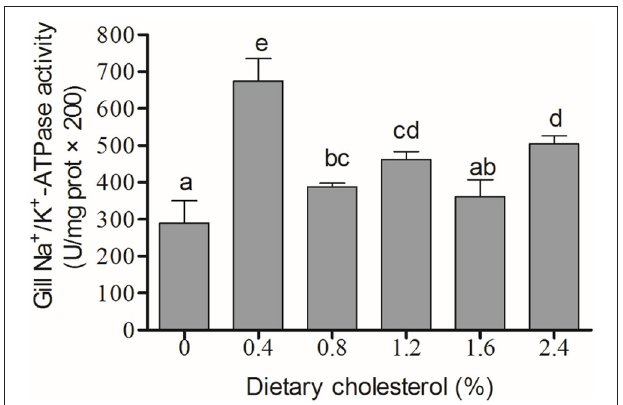
FIGURE 3 | The activity of Na + /K + -ATPase in the gill. The abscissa indicates the diets, with the different cholesterol percentages labeled as 0, 0.4, 0.8, 1.2, 1.6, and 2.4%. The ordinate represents the activity of Na + /K + -ATPase, and the units are U/(mg protein). The different lowercase letters represent significant differences among groups ( P < 0.05). Values (mean ± S.E.) of the Na + /K + -ATPase activity are the mean of nine fish.